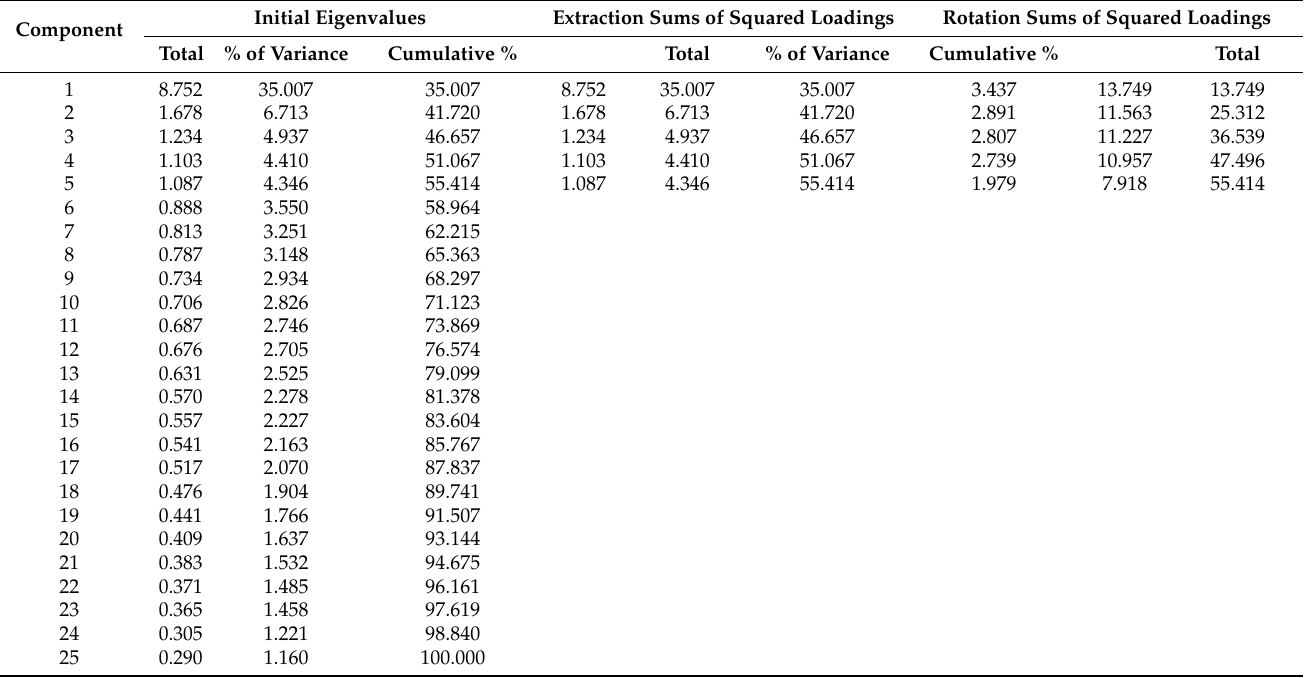
Table 4. Total variance explained (independent variables).